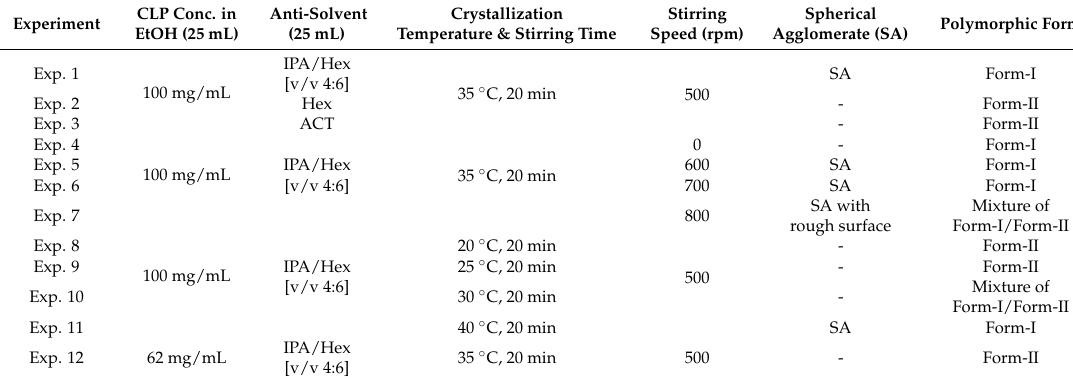
Table 1. Experimental Conditions for Spherical Crystallization of Clopidogrel Bisulfate Form-I via Anti-Solvent Crystallization Method and Resulting Polymorphic